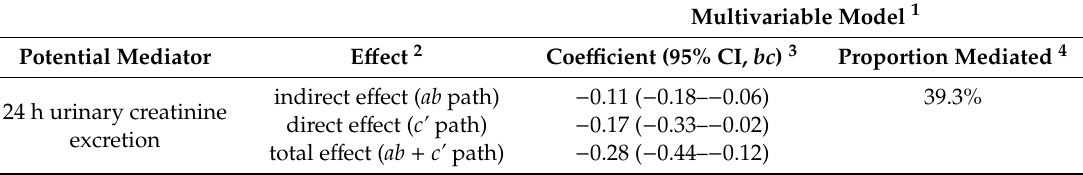
Table 4. Mediation analysis of the relationship between plasma IGF1, 24 h urinary creatinine excretion, and all-cause mortality in female